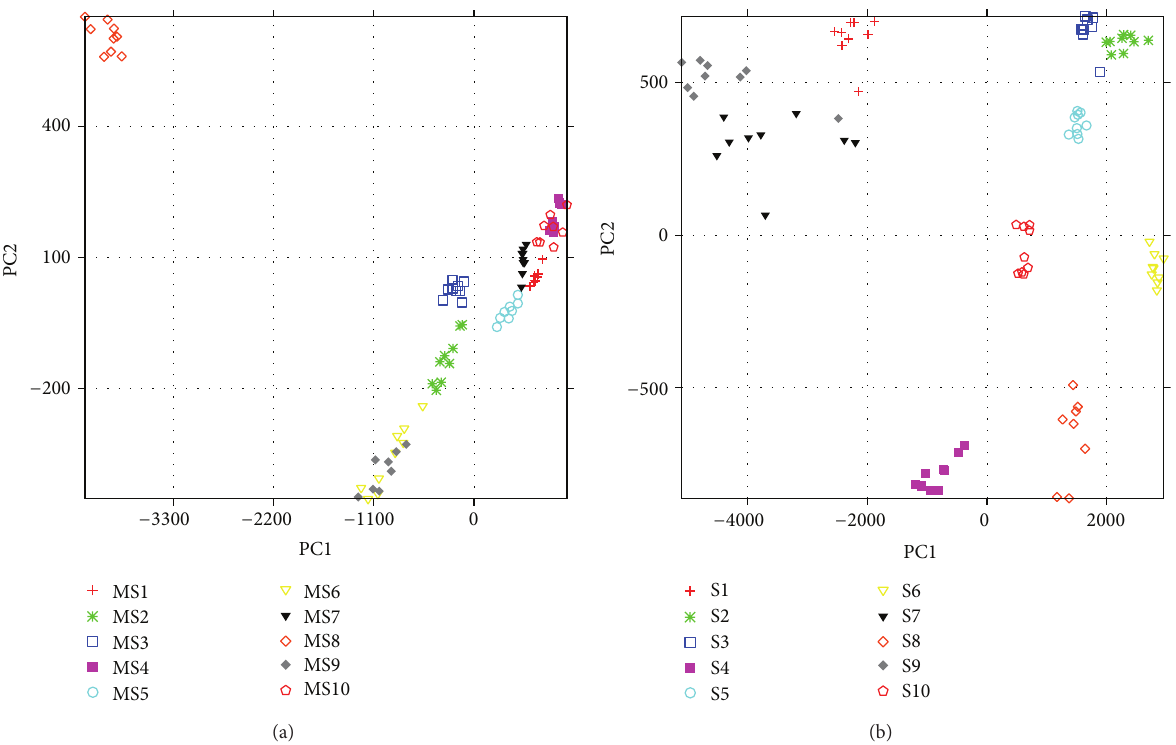
Figure 5: Intrasubject variability represented by first two principal components as shown by PC1 and PC2 for ten different subjects of (a) MIT-BIH arrhythmia database and (b) IIT (BHU) database.